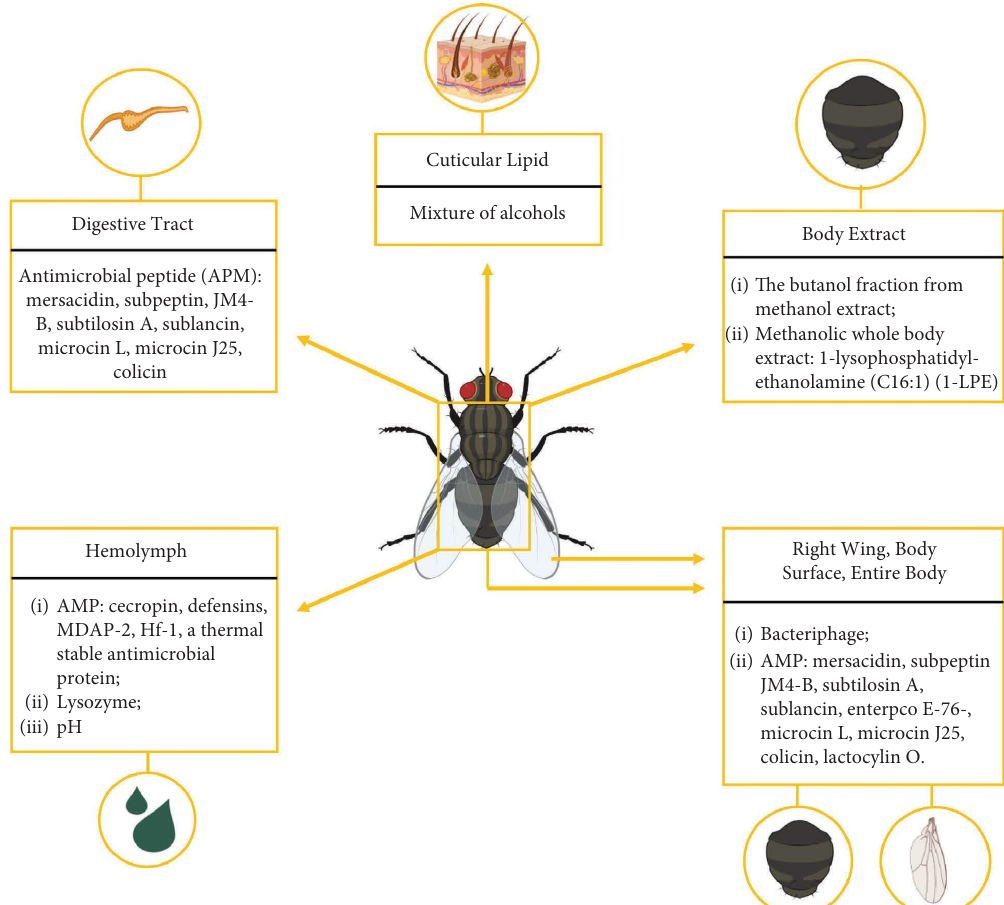
Figure 1: Antimicrobial components of M. domestica and their